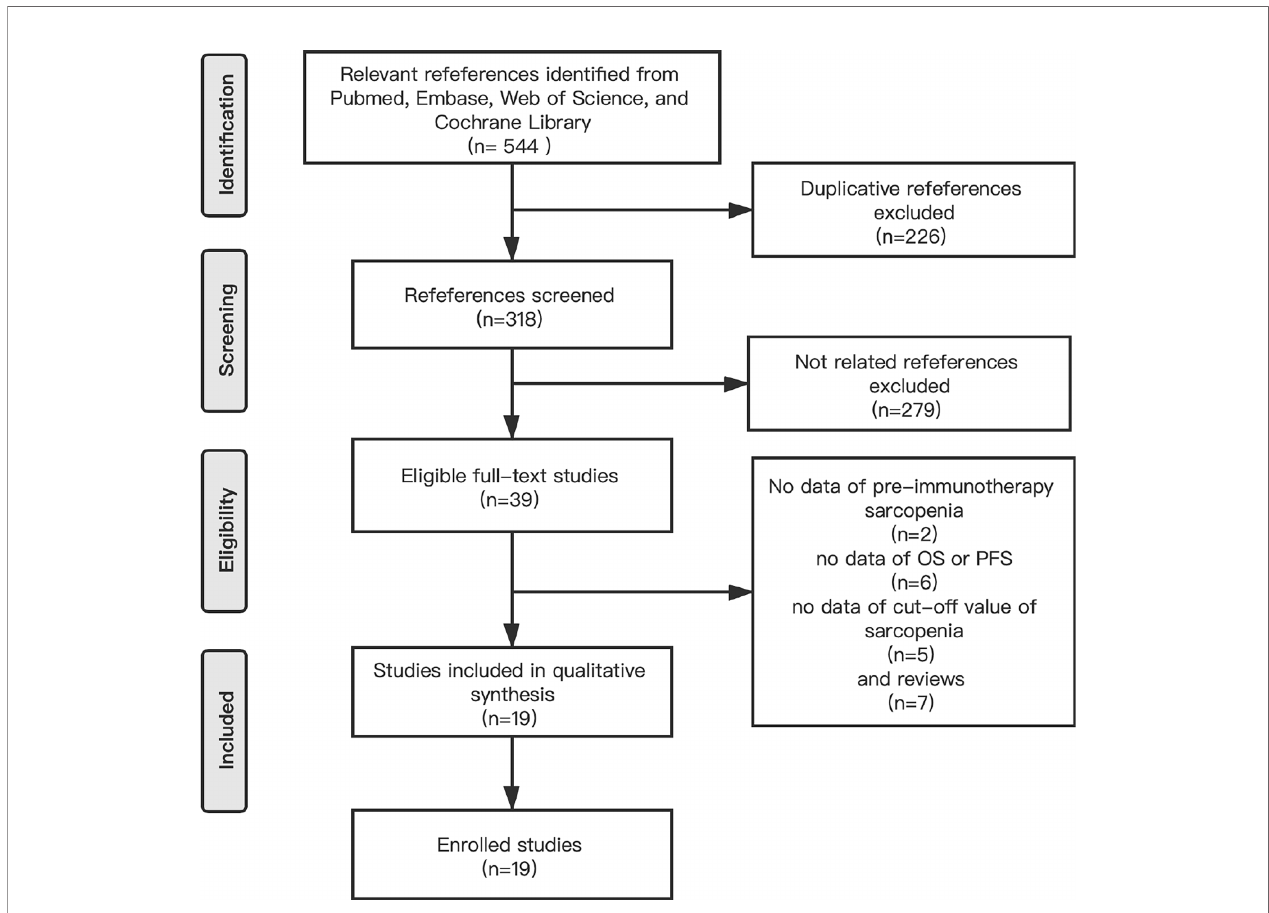
FIGURE 1 | A fl ow chart of studies selection